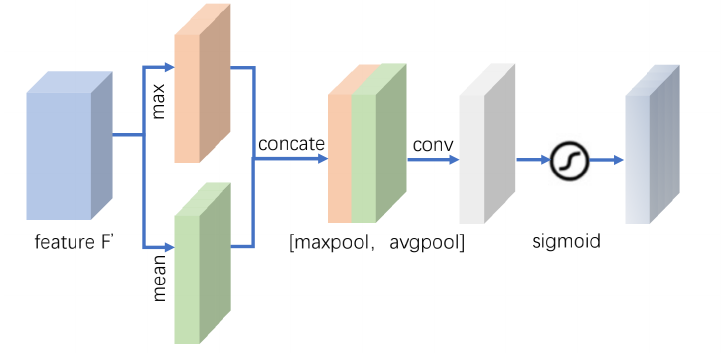
Figure 9. Spatial attention